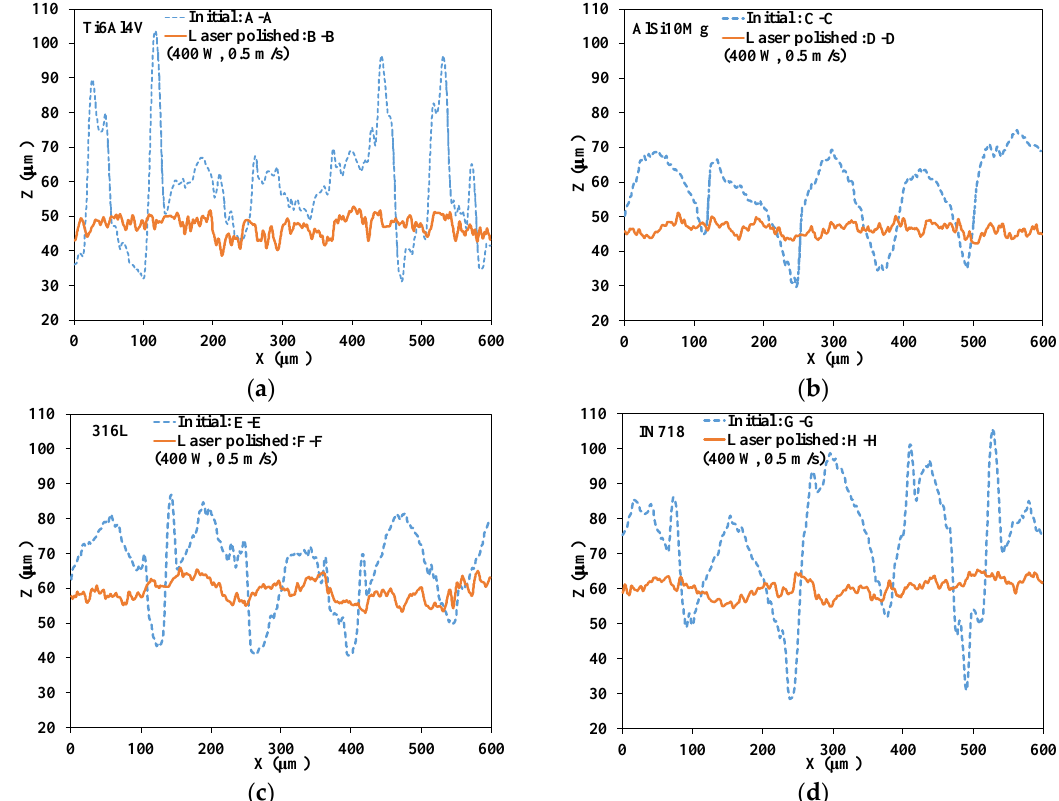
Figure 8. Data plot of line profiles extracted from three-dimensional contours: ( a ) Ti6Al4V, ( b ) AlSi10Mg, ( c ) 316L and ( d ) IN718.